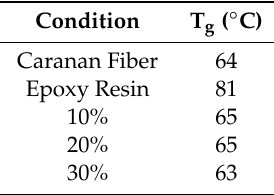
Table 5. Glass transition temperature (Tg) for different material conditions.